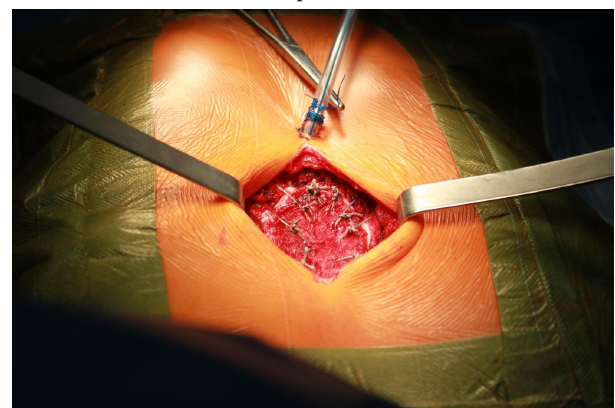
wedge-shaped recesses (the main highlights of the modified Ravitch procedure).